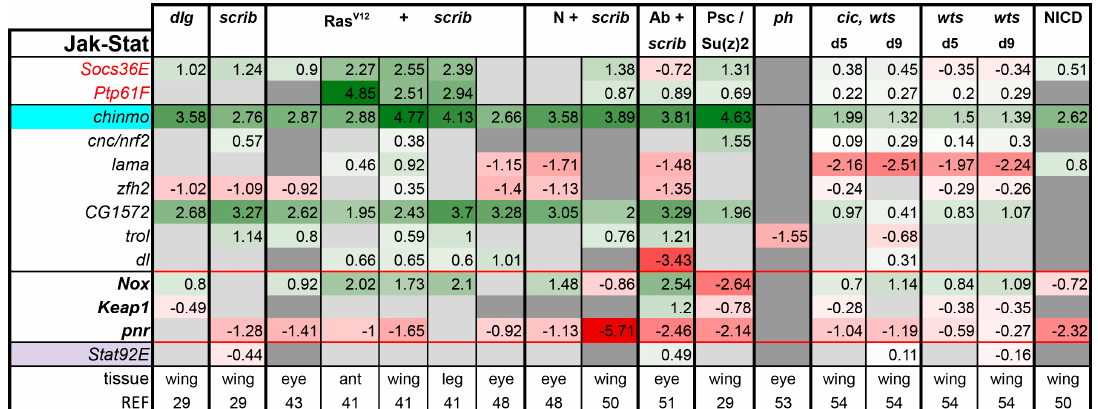
Figure 6. Most tumors have high levels of JAK / STAT activity. The target genes that are suppressed by the pathway are shown in bold, and pathway inhibitors are shown in red. Light purple highlights the transcription factor of the pathway. Gene expression is displayed in log2FC. Color coding corresponds to a heatmap with a scale from − 5 (dark red) to 5 (dark green). Light grey cells represent non-significant changes with p ≥ 0.05. Dark grey: the gene was not found in the dataset. Abbreviations: Suppressor of Cytokine Signaling at 36E, Socs36E ; Protein tyrosine phosphatase 61F, Ptp61F; chronologically inappropriate morphogenesis, chinmo; cap-n-collar, cnc; lamina ancestor, lama; Zn finger homeodomain 2, zfh2 ; terribly reduced optic lobes, trol; dorsal, dl; NADPH oxidase, Nox ; Keap1, Keap1 ; and pannier, pnr